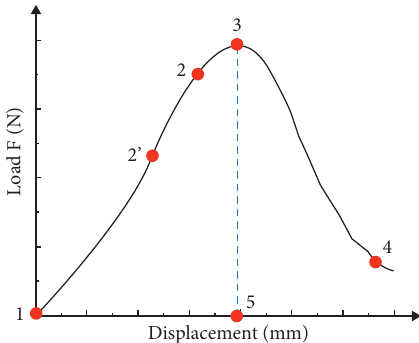
Figure 11: Typical load-displacement curve of the TPB test for